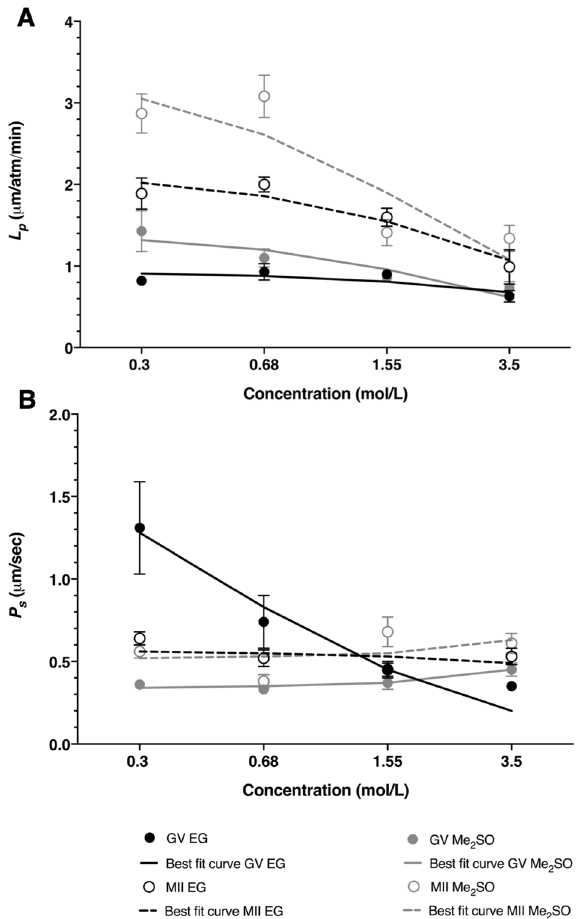
Figure 2. Water permeability and solute permeability GV (closed circles) and MII (open circles) oocytes in the presence of increasing concentration of CPA (EG (black) or Me 2 SO (gray)) for the 2P model ( A , B , respectively). Best-fit curve for the concentration dependent model represented by a solid black line (GV EG), dotted black line (MII EG), solid gray line (GV Me 2 SO) and dotted gray line (MII Me 2 SO). Unless indicated otherwise, data are given as the mean ± s.e.m.